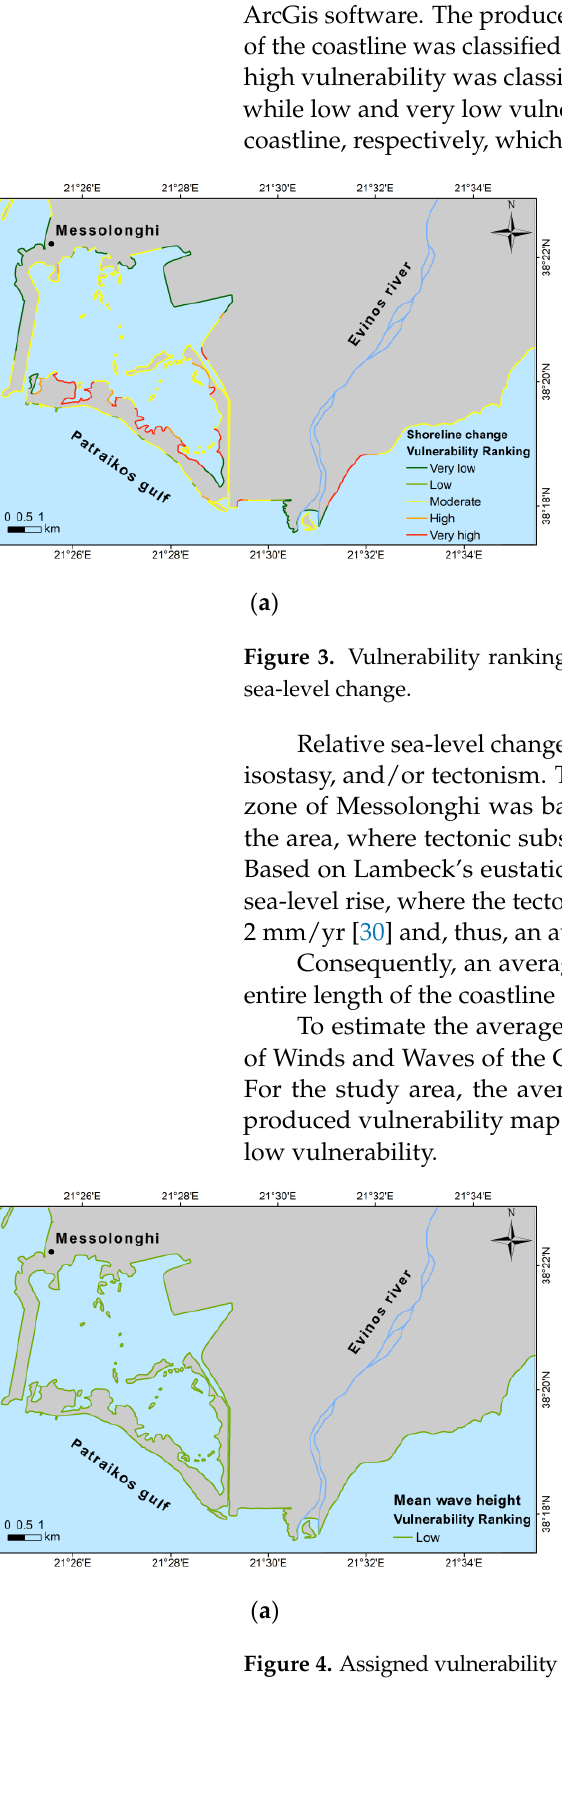
( b ) Figure 2. Assigned vulnerability classes in response to ( a ) geomorphology and ( b ) coastal slope. To examine diachronic changes on the coastline, the ArcGis software was used along with the extension “Digital Shoreline Analysis System” (DSAS) v5 software [39], which is freely available from the US Geological Survey (USGS). Initially, the position of the coast- line of the study area, in two different years (aerial photographs of the year 1945 and Google Earth for the year 2018), was digitized and then two coastlines were compared using the ArcGis software. The produced vulnerability map (Figure 3a) revealed that the largest part of the coastline was classified as moderate (61.07 km, 60.42% of the coastline). High to very high vulnerability was classified as 17.04% (17.22 km) of the total length of the coastline, while low and very low vulnerability were classified as about 2.92 km and